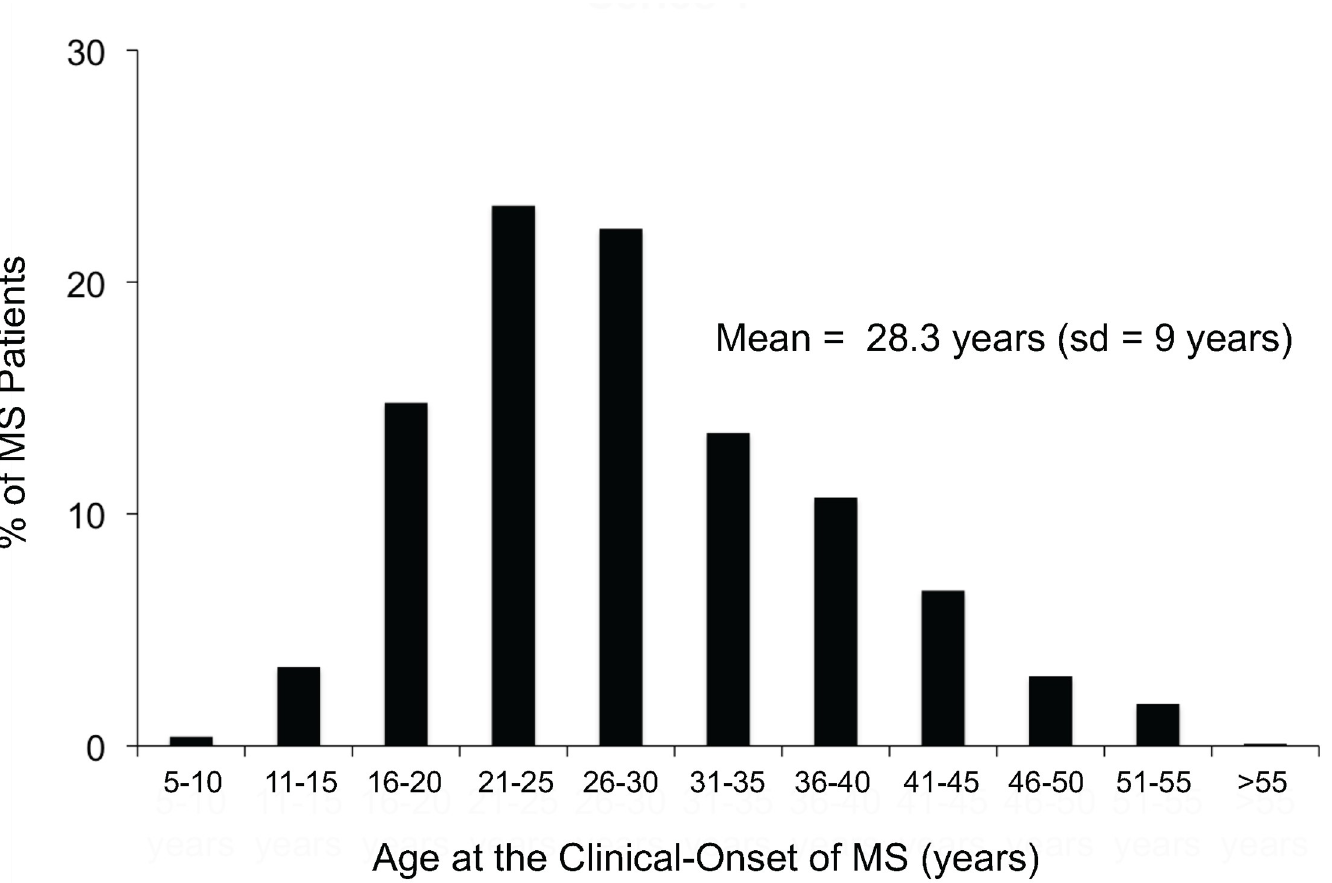
Fig 1. The distribution of the age at the clinical-onset of disease in a cohort of 1,463 patients with MS (sd = standard deviation). Data from Liguori et al . [ 35 ].